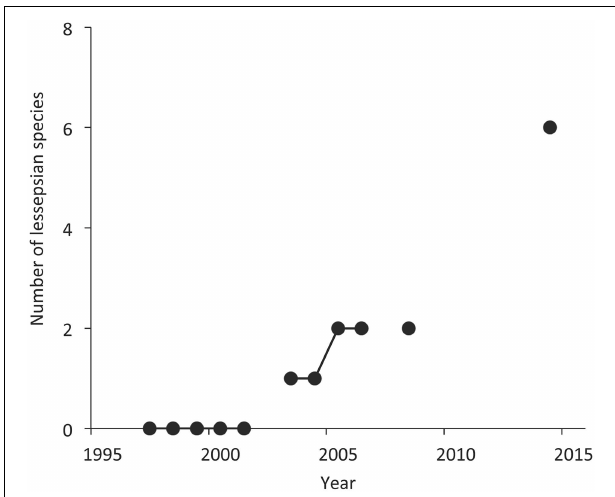
FIGURE 4 | The number of Lessepsian species caught per year in the MEDITS experimental bottom trawl survey data in the southern Aegean Sea